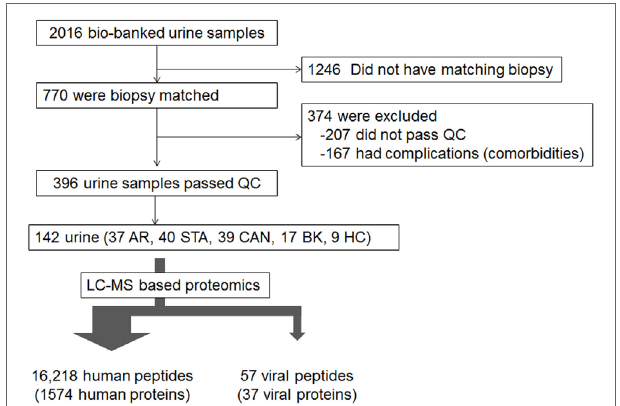
FigUre 1 | Source of samples. LC-MS based proteomics was performed on the 142 samples chosen: 37 with acute rejection (AR), 40 stable (STA), 39 with chronic allograft nephropathy (CAN), 17 with BK virus nephritis, and 9 healthy controls.